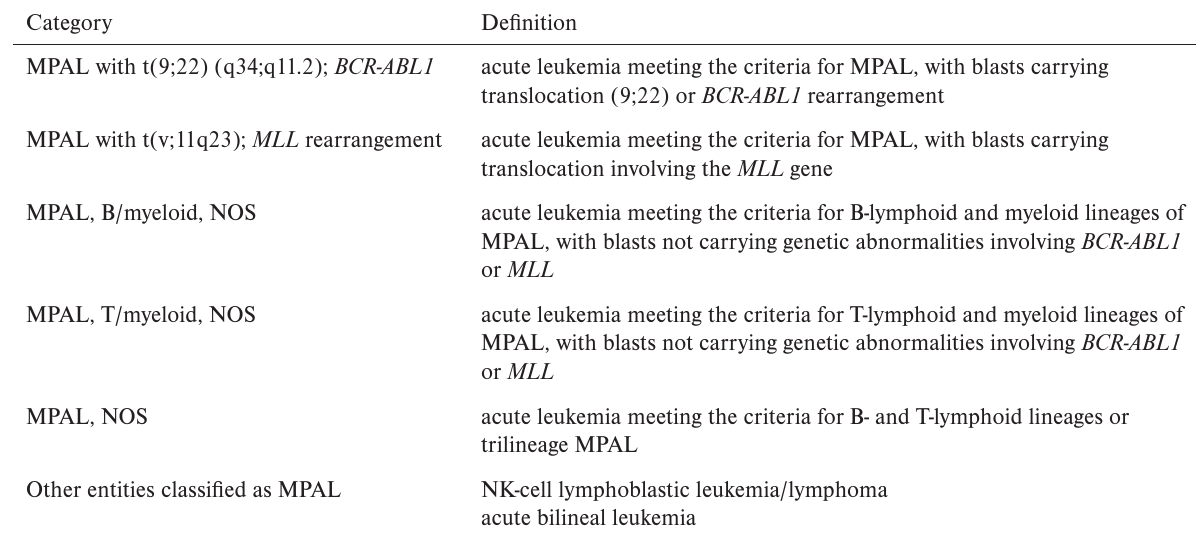
Table 3. Categories of MPAL according to the 2008 WHO classification 4